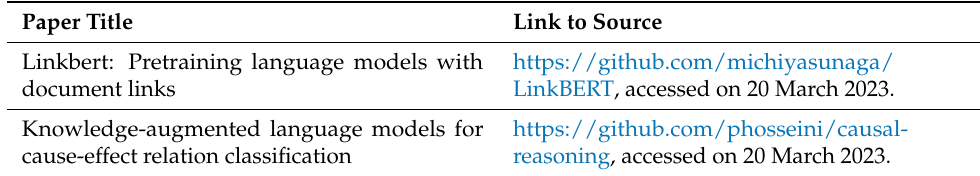
Table 4. Source code links for Text